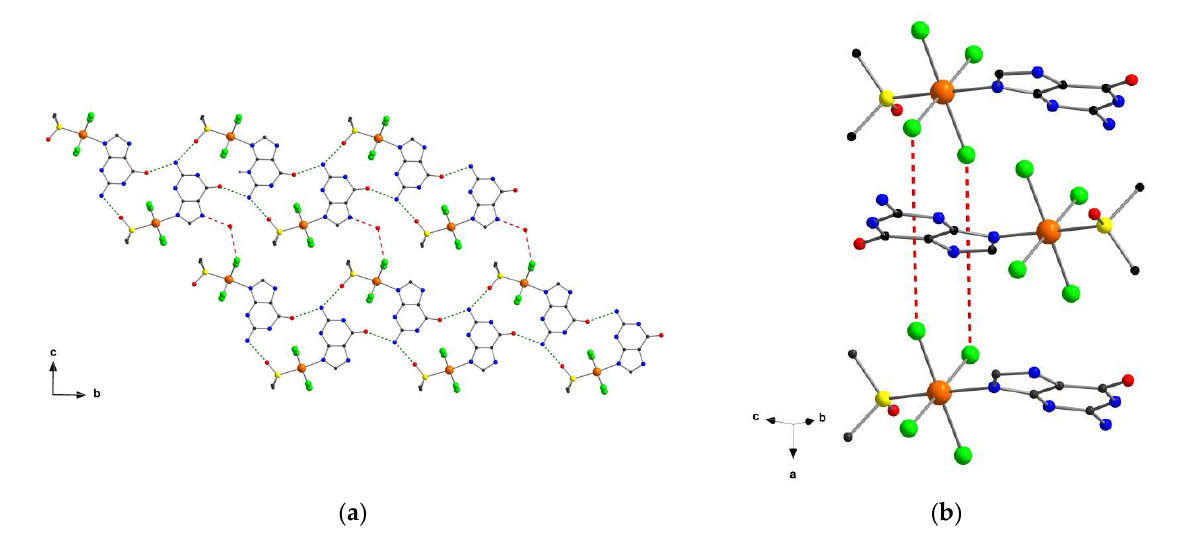
Figure 2. ( a ) A fragment of the crystal of 1 showing hydrogen bonds involving [RuCl 4 (Hgua)(dmso)] units (dashed green lines), and [RuCl 4 (Hgua)(dmso)] complexes and water molecules (dashed red lines), along the crystallographic a axis; ( b ) Detail of the Ru–Cl ··· π ··· Cl–Ru interaction (dashed red lines) generated by alternate [RuCl 4 (Hgua)(dmso)] complexes in 1 .